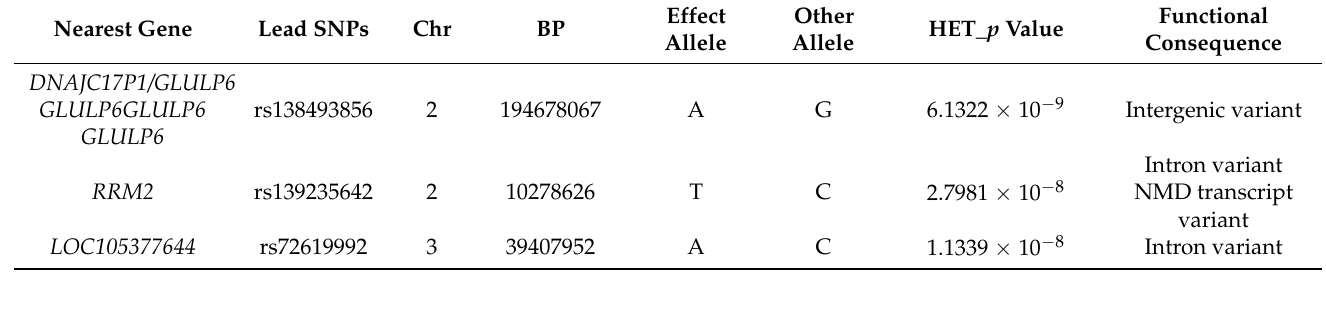
Figure 4. Regional visualization of the GWAS of − log10 of the p -value of genomic location MOBP (rs562545 in purple) ( A ) and AC074290.1 (rs77534700 in purple) ( B ), with each dot representing SNP on the corresponding genes at the bottom. Table 3. Novel variants of blood-pressure traits identified using multivariate methods.